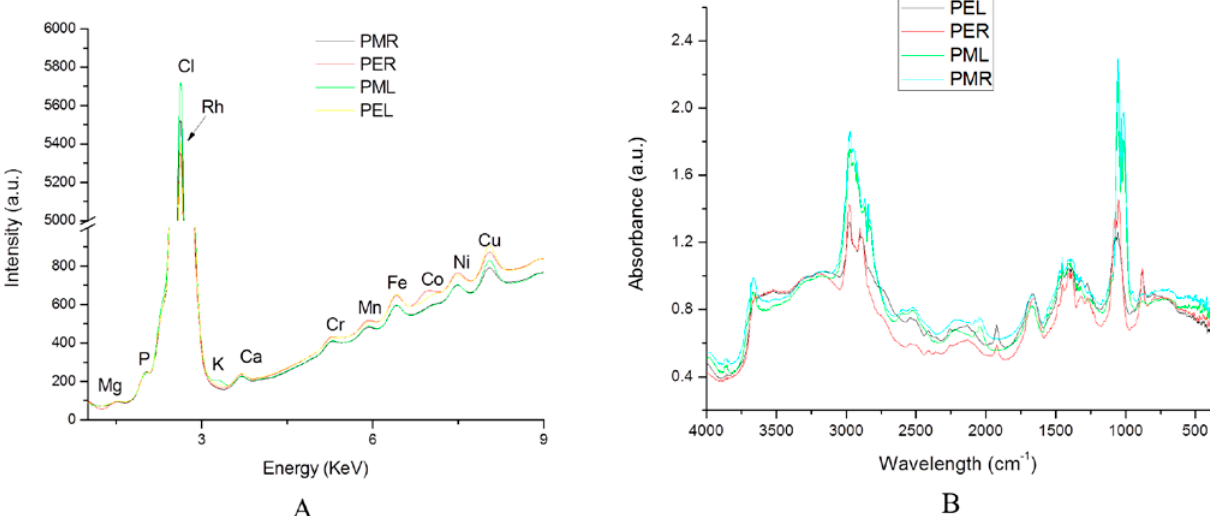
Fig. 1. EDXRF spectra (A) and FTIR spectra (B) of the ethanol and methanol extracts of Polystichum setiferum (Forssk.) Moore ex